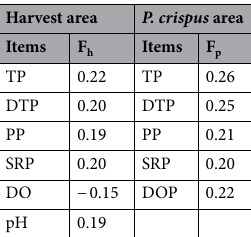
Table 2. PCA score coefficient matrix of harvest area and P. crispus area.